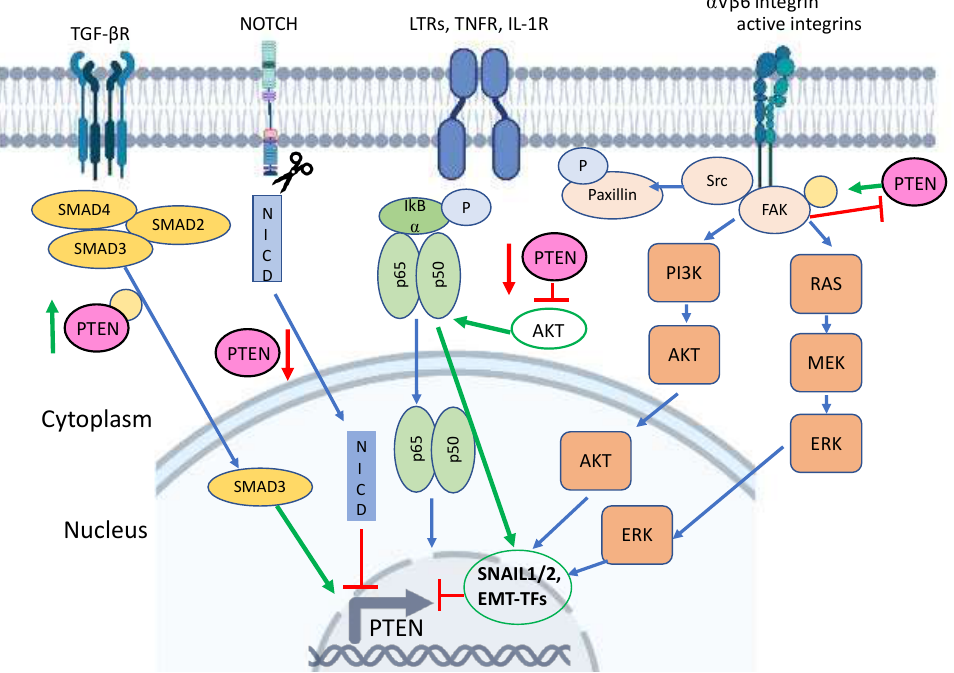
Figure 4. Positive and negative effects of PTEN on TGF- β , Notch, TNF, and integrin signaling pathways. Upon binding of TGF- β , the TGF- β receptor (TGF- β R) induces the phosphorylation of and nuclear translocation of SMADs, while the latter regulate transcription of EMT factors. TGF- β may potentially increase the protein level of PTEN via its phosphorylation. Notch signaling also regulates the expression of PTEN. The cleaved part of Notch receptors affects the transcription of different genes, including PTEN, which is a direct transcriptional target of Notch3. Notch1 downregulates PTEN expression. The NF- κ B (Nuclear factor- κ B) pathway is activated via LTRs, TNF receptors, and receptors for cytokines (e.g., IL-1R). The NF κ B family consists of five subunits: Rel (c-Rel), p65 (RelA, NF κ B3), RelB, p50 (NF κ B1), and p52 (NF κ B2). AKT-dependent activation of NF- κ B induces the expression of Snail, which in turn inhibits the expression of PTEN, thereby forming the PTEN/Akt/NF- κ B/Snail feedback loop. Integrins are involved in the regulation of cell adhesion to an extracellular matrix. The expression of PTEN inhibits migration and invasion through the α V β 6 integrin signaling pathway. There is a crosstalk between PTEN and FAK. On the one hand, PTEN interacts with and de-phosphorylates FAK tyrosine kinase thereby inhibiting the integrin-mediated migration and invasion of cancer cells. On the other hand, FAK phosphorylates PTEN at Tyr336, which increases the phosphatase activity and protein stability of PTEN. Interactions of PTEN with FAK and paxillin, respectively, weaken their interactions with ECM components. Thus, PTEN may contribute to the process of destabilization of cell adhesion to